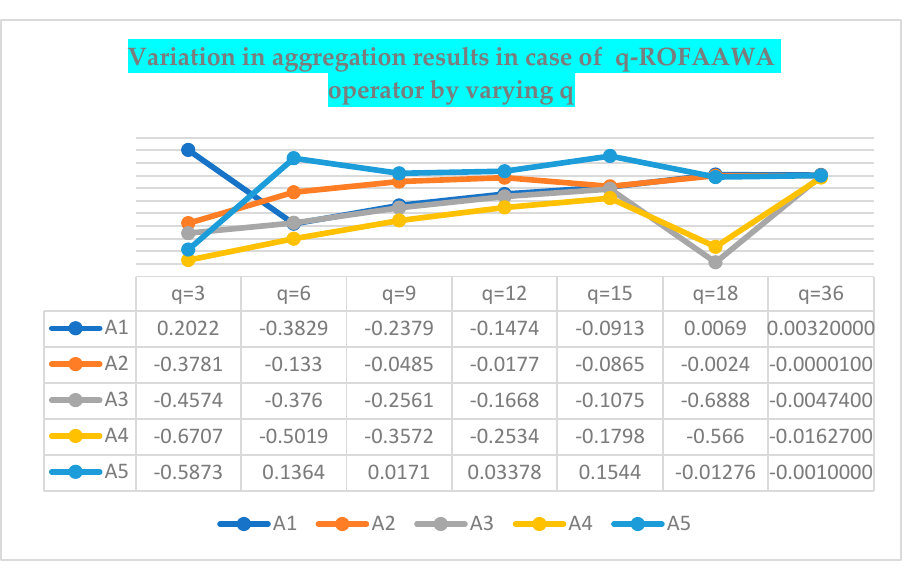
Figure 4. The geometric representation of score value, variation by q. Lines on horizontal lines represent the raking of score values, and here vertical line shows the range of score values of [ − 1, 1 ] . The geometrical illustration of the ranking order in Table 9 is presented in Figure 5. Here, lines on horizontal lines represent the values of the SF, and vertical lines denote the range of score values of [ − 1, 1 ]